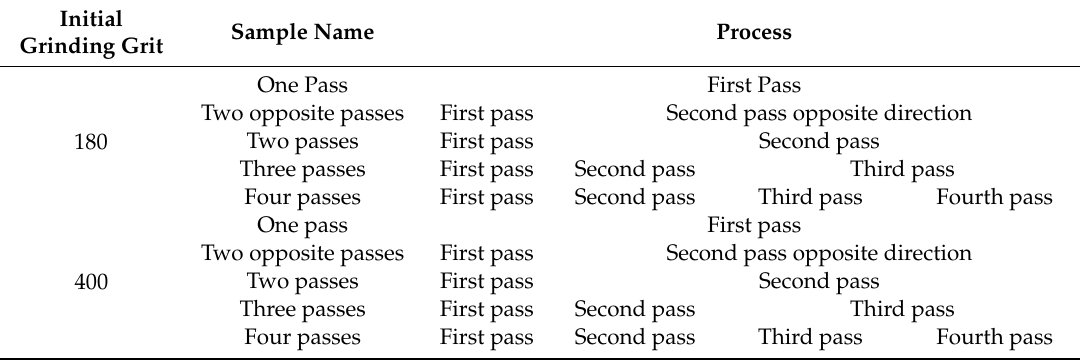
Figure 1. Schematic set-up for the multi-pass burnishing process [20]. Table 2. Sample procedure for all multi-pass burnishing processes.